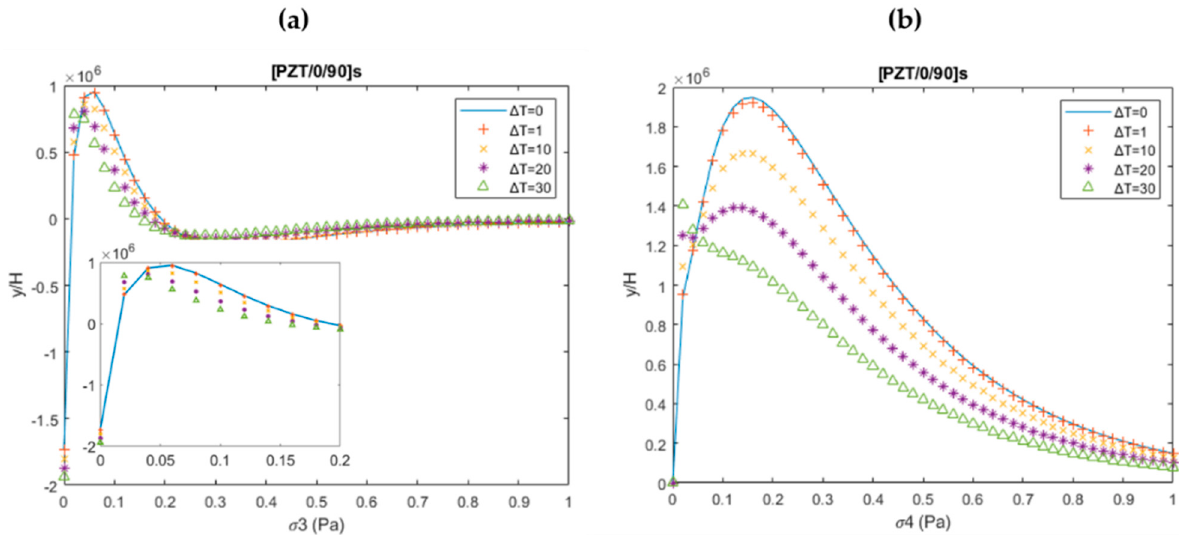
Figure 6. ( a ) σ 3 at the PZT/0 interface of cross-ply laminate under the combined 0.1% uniaxial extension thermal loading and variable temperature loadings ( ∆ T = (0, 1, 10, 20, and 30); ( b ) σ 4 at the 0/90 interface under the combined 0.1% uniaxial extension thermal loading and variable temperature loadings ( ∆ T = (0, 1, 10, 20, and